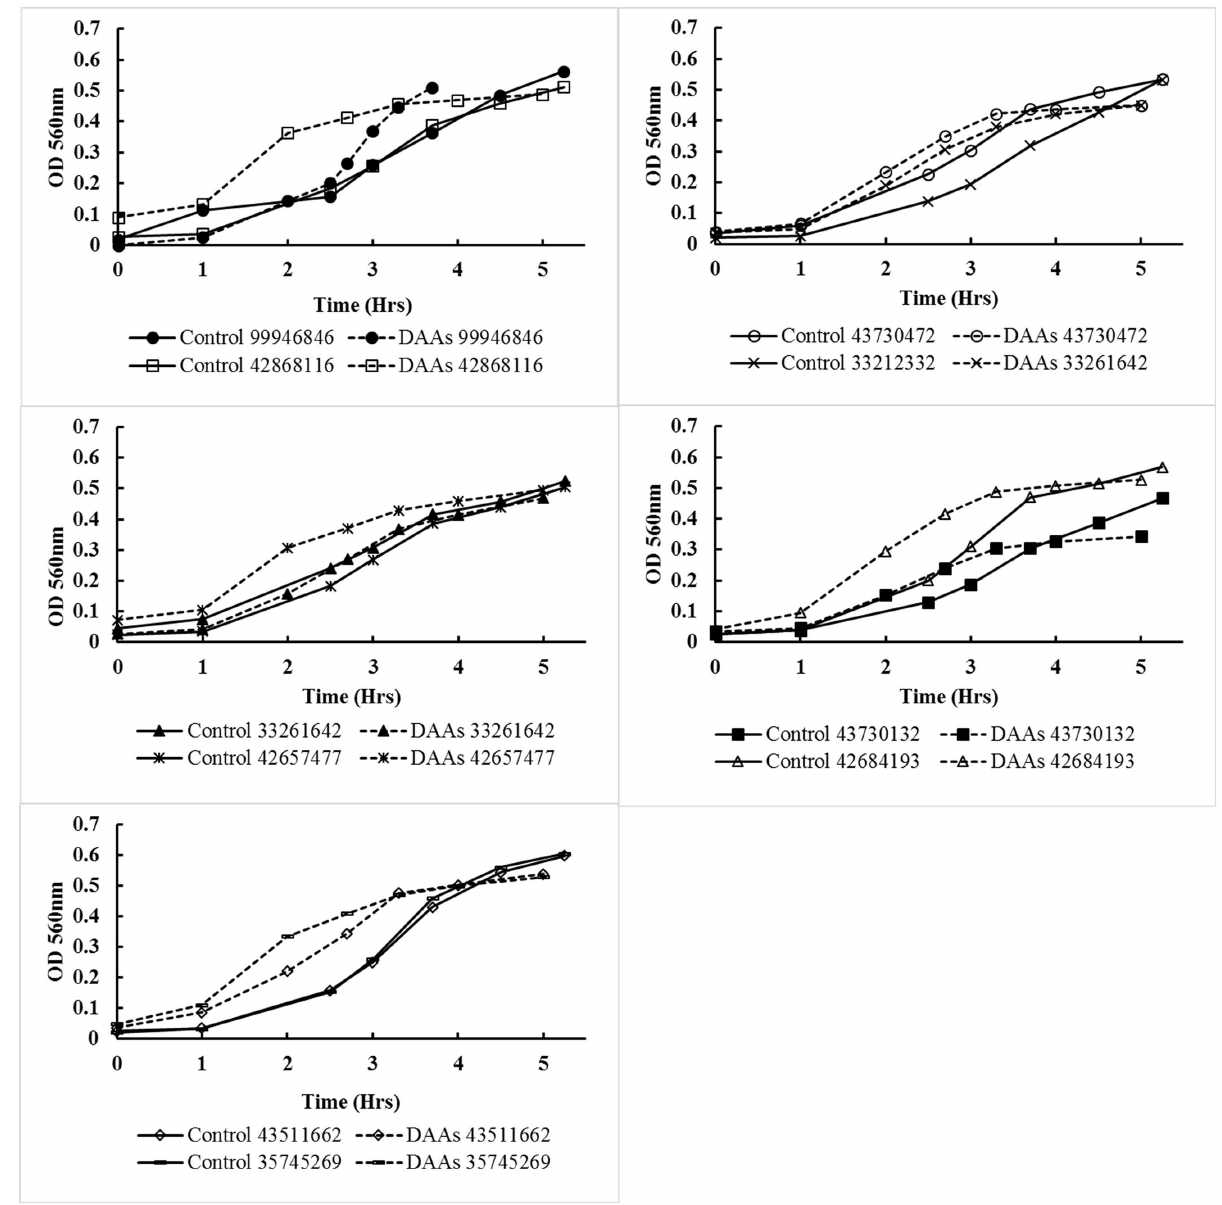
Fig 2. The effect of DAAs on the growth rate of E . faecalis . The growth rate as shown by optical density of each E . faecalis strain after the additionof 25mM D-Leu, D-Met and D-Trp and 0.25mM D-Tyr. DAAs were excludedfrom the